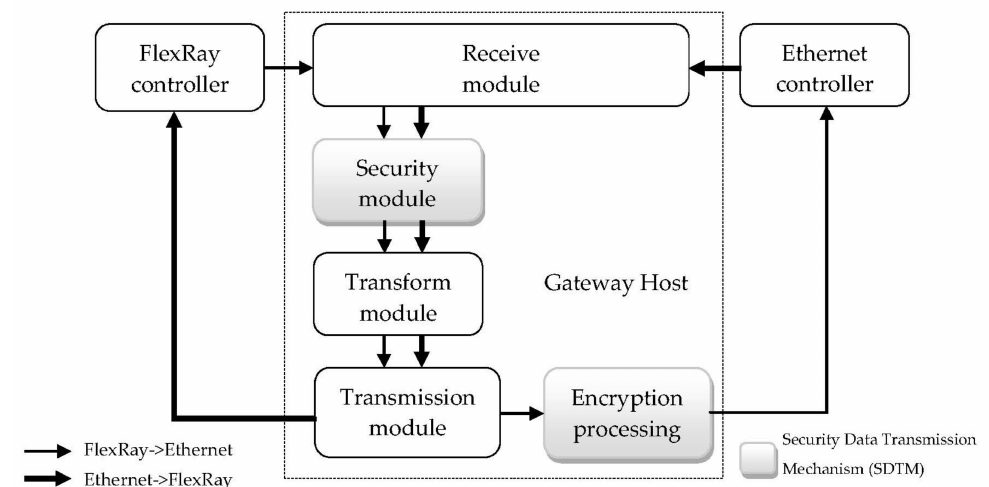
Figure 2. The proposed FlexRay / Ethernet gateway architecture and data